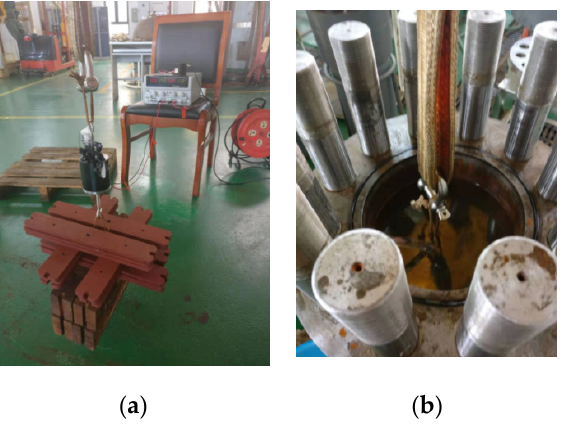
Figure 19. ( a ) Magnetic adhesion test of the electromagnet; ( b ) magnetic adhesion test in the pres- sure chamber.